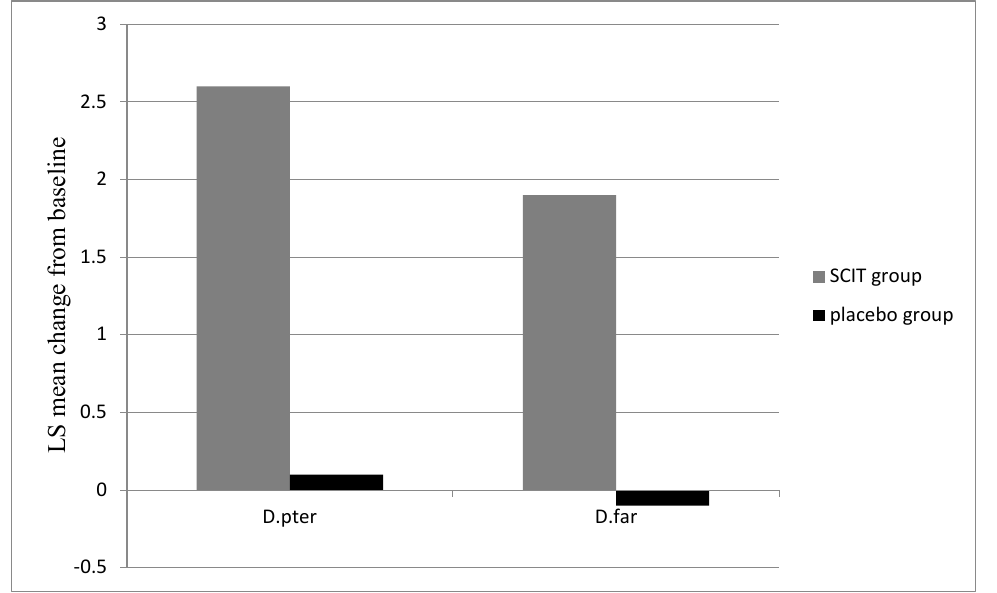
Figure 4. Increase in HDM-specific IgG4 levels (SE) after 12 months from the start of treatment in the SCIT group. D. pter —mean change in IgG 4 against D. pteronyssinus from baseline; D. far —mean change of IgG 4 against D. farinae from baseline. Treatment safety assessment.